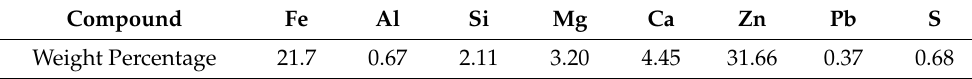
Table 1. Composition of the EAFD used in the present study.